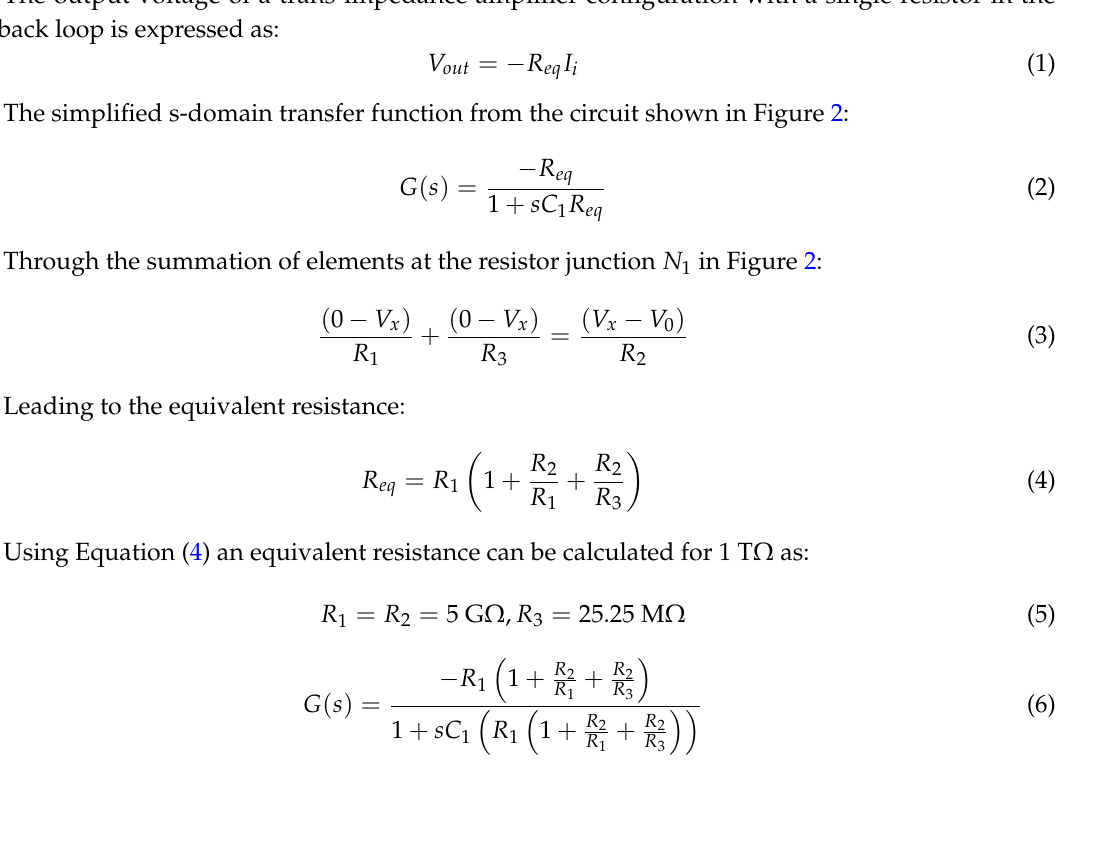
Figure 2. Schematic of the low impedance capacitive sensor design with highlighted T-network R eq . The addition of a capacitor C 1 to the feedback loop prevents oscillation and aids in stability of the circuit [21] whilst limiting the